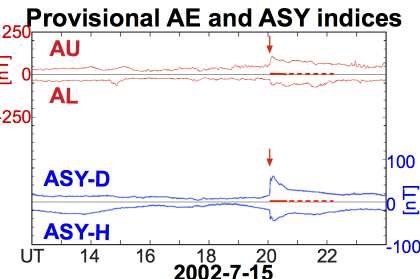
Figure 6. Web-interfaced plots of provisional AE and ASY indices for 15 July 2002. The red horizontal lines correspond to the period when the X-ray flux exceeds 3 × 10 − 5 Wm − 2 ( > M3 class – solid lines) and 10 − 5 Wm − 2 ( > M class – dashed lines). The vertical red arrow denotes the start of the crochet.